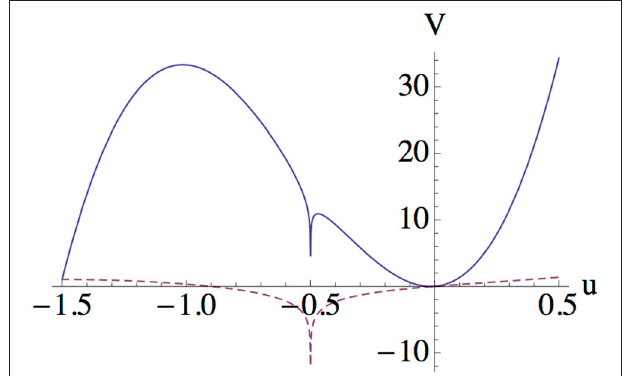
FIGURE 3 | Effective potential for u , where solid line is a plot for g = 0.1 while dashed line is for g = 1.0.